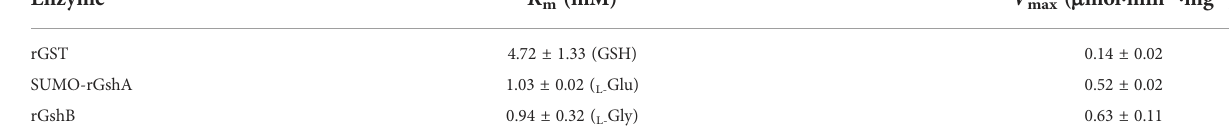
TABLE 1 K m and V max of rGST, SUMO-rGshA and rGshB.